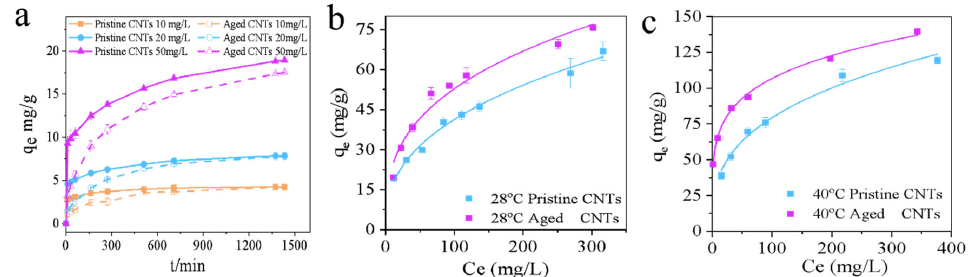
Figure 3. ( a ) The adsorption kinetic curve of TC on pristine and aged CNTs; Adsorption isotherms fitted with the Freundlich model of TC at 28 °C ( b ) and 40 °C ( c ).